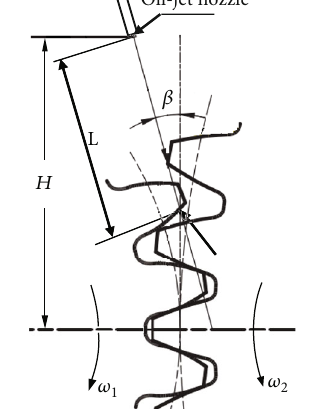
Figure 3: Layout parameters of the nozzle. Table 4: Layout parameters of the